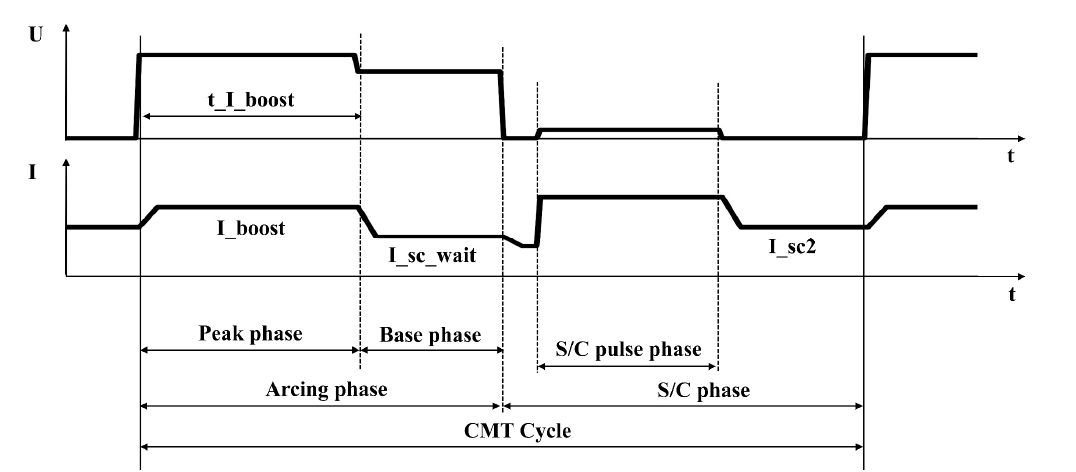
Figure 2. Schematic of voltage and current waveforms during CMT welding process of Mg alloy.